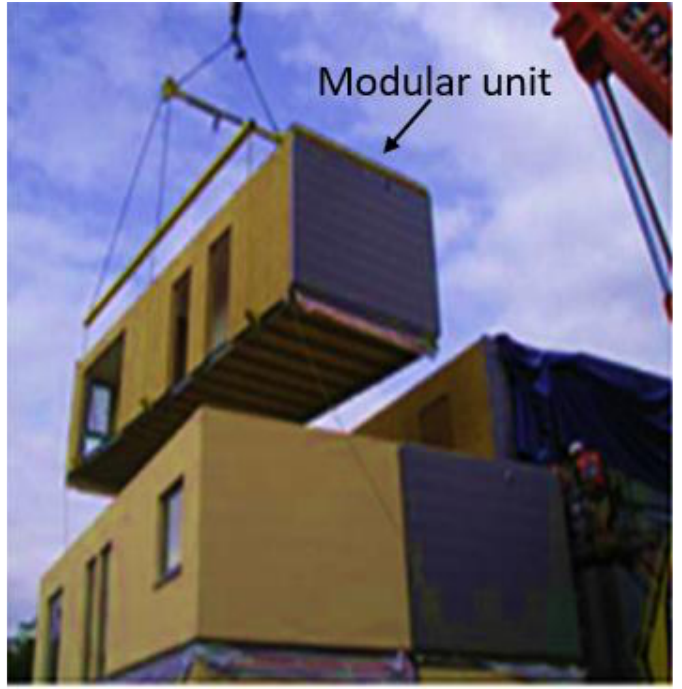
Figure 4. Typical modular units [40] .